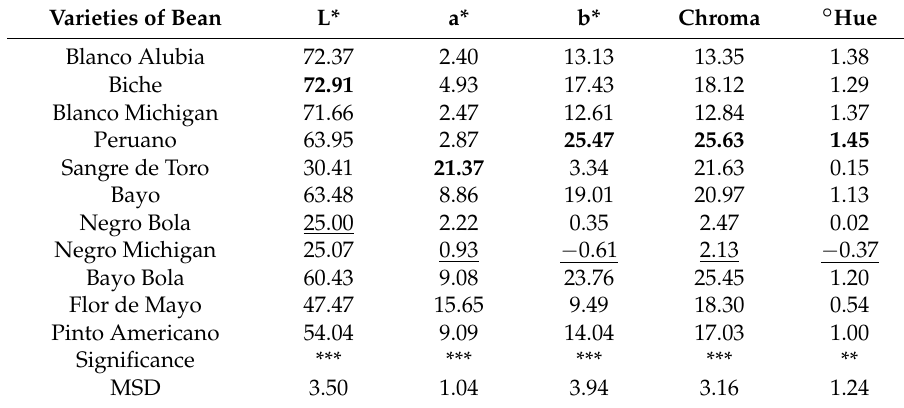
Table 3. Determination of colorimetry in bean varieties produced and consumed in the State of Oaxaca,